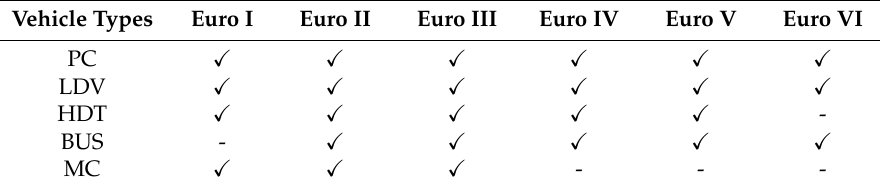
Table 2. Vehicle emission standards in Minnesota, North America, in 2015.